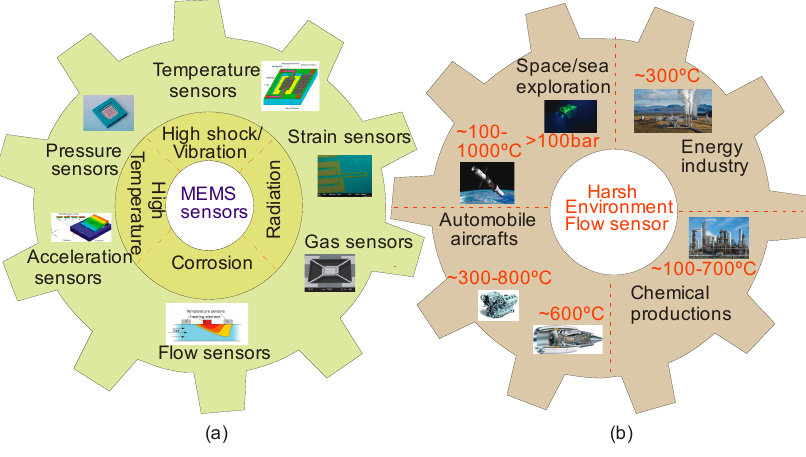
Figure 1. ( a ) Various MEMS sensors and harsh environments; ( b ) Applications of MEMS flow sensors and their corresponding conditions.